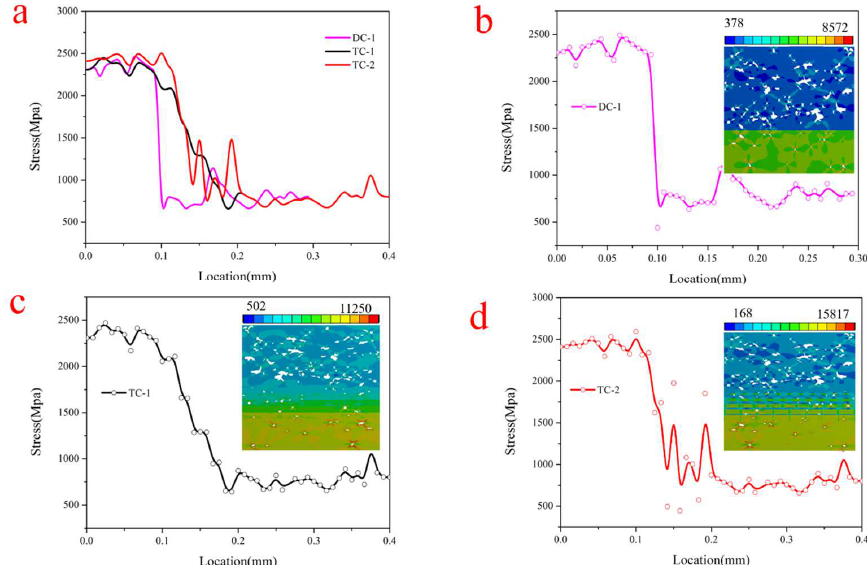
Figure 8. Stress distribution of the model with pores along the vertical axis of symmetry ( a ), thermal stress distribution of traditional coating ( b ) and continuous transition coating with pores ( c , d ).